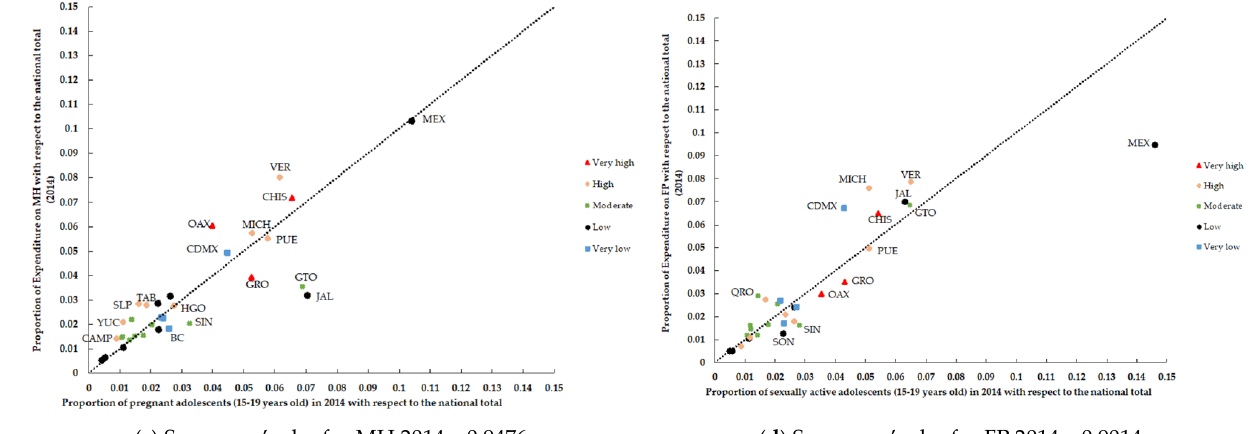
( c ) Spearman’s rho for MH 2014 = 0.9476. ( d ) Spearman’s rho for FP 2014 = 0.9014. Figure 4. Concentration curves and correlations: government MH and FP expenditure for adolescent women (15–19 years old) without Social Security coverage but with potential demand indicators (Mexico, 2009 and 2014).